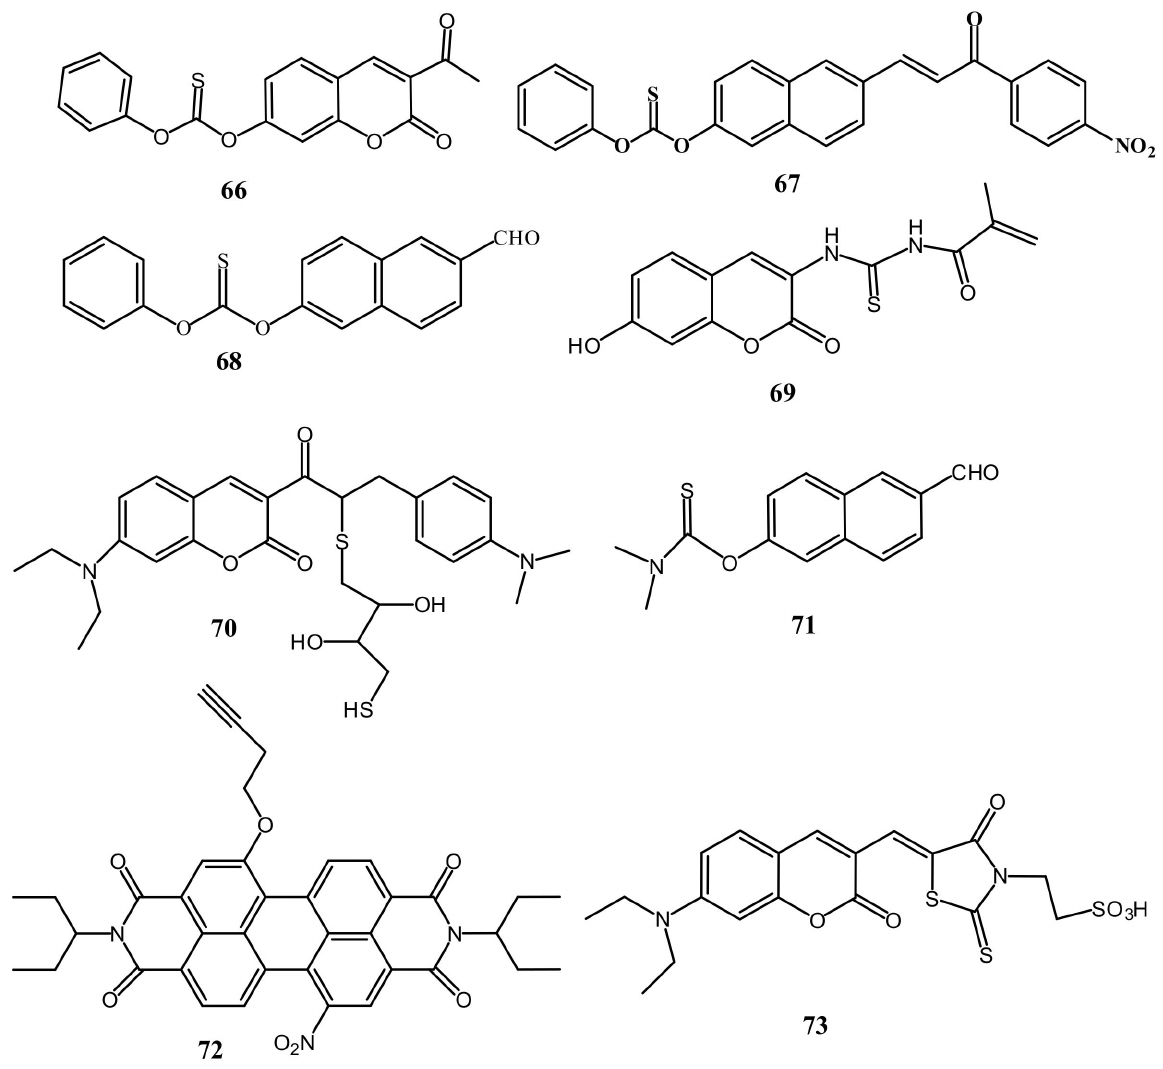
Figure 23. Molecular structures of the sensors 66 to 73